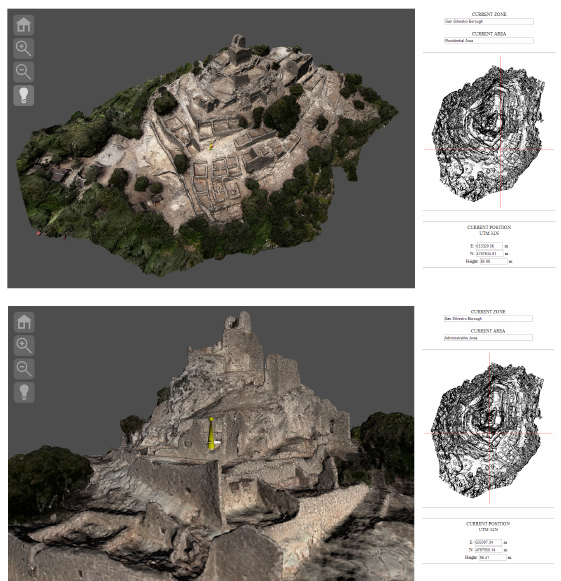
Figure 7: Two snapshots of bird’s eye navigation of San Silvestro model